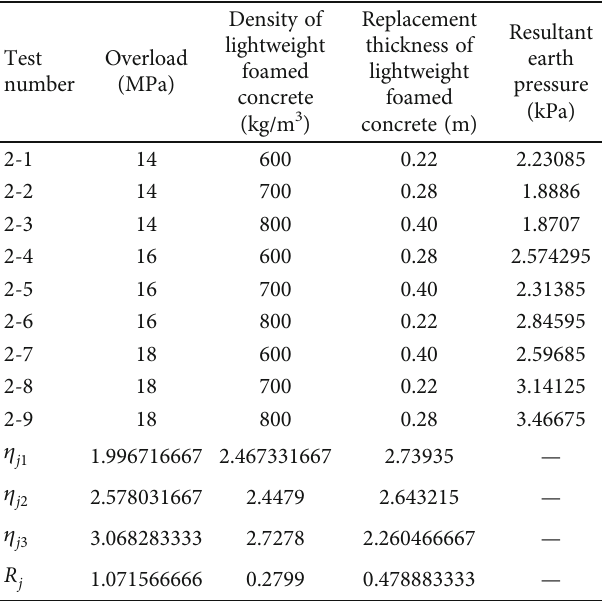
Table 8: Results of the point of resultant force by multiple-factor orthogonal